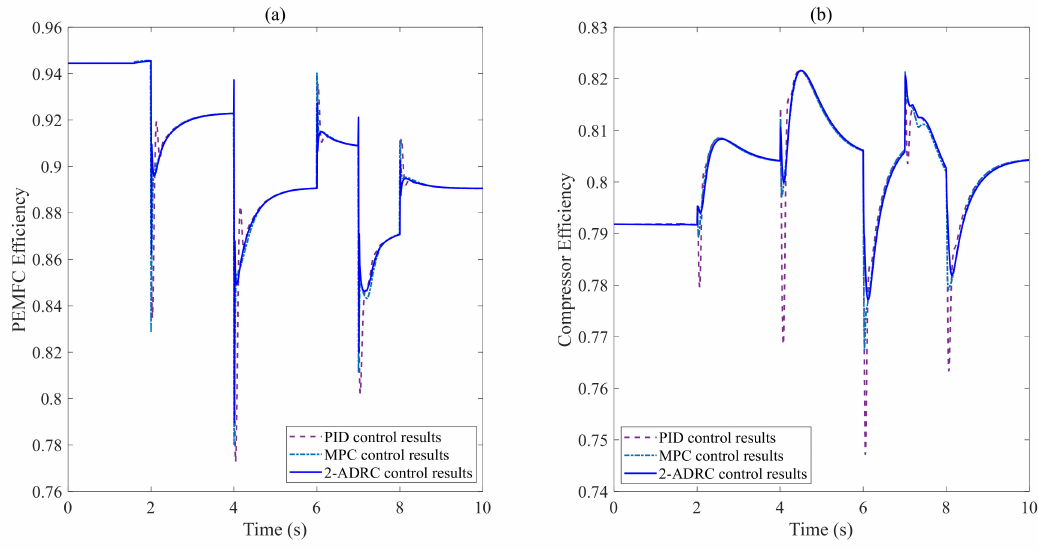
Figure 10. Efficiency simulation results: ( a ) PEMFC efficiency; ( b ) Compressor